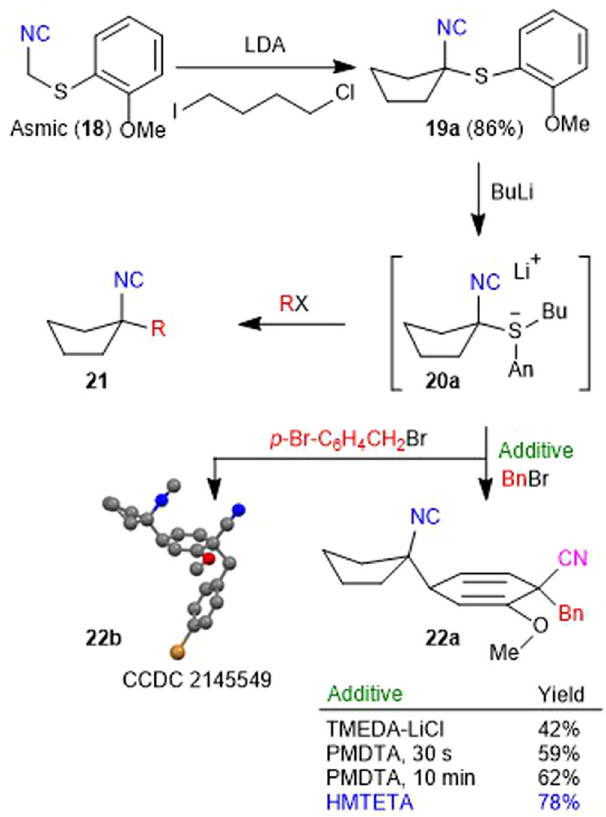
Fig. 3 | Optimization of the dearomatization for isocyanide 19a. Alkylation of Asmic( 18 )providesthecorescaffoldthatwasdearomatizedviasulfuranide 20a to cyclohexadienes 22a and 22b